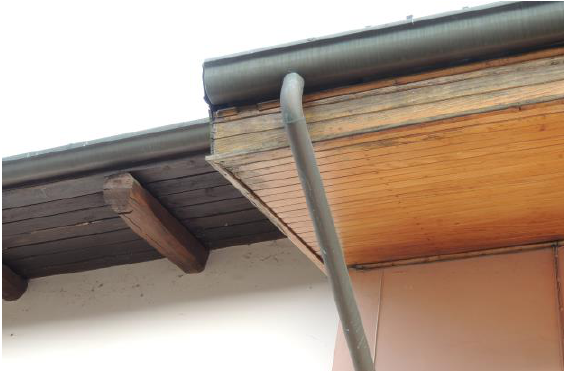
Figure 9. Building E - Wooden battens in the overhang of the roof (credits Fabio Fratini).